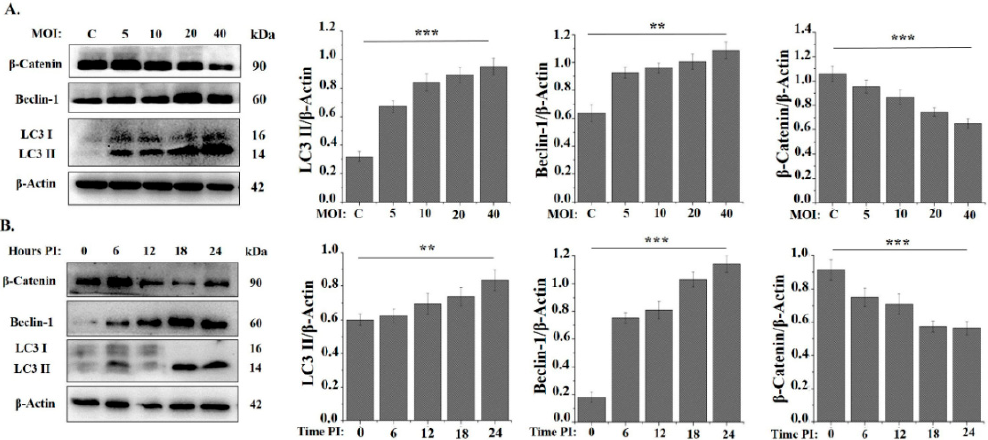
Figure 2. Mycobacterium bovis C68004 ( M. bovis ) infection induces autophagy in murine bone marrow derived macrophages (BMDMs) in a dose- (MOI) and time-dependent manner. ( A ) Murine BMDMs were infected with M. bovis C68004 at a variable MOI (5, 10, 20 and 40) and incubated for indicated time period. Expression of autophagic markers like LC3 II, Beclin-1 and β -Catenin was determined by the Western Blot analysis in infected and un-infected control BMDMs; ( B ) murine BMDMs were infected with M. bovis C68004 at a MOI of 10 and incubated for indicated time periods (0, 6, 12, 18, 24 h). Expression of autophagic markers was determined by the Western Blot analysis and expression levels of various proteins were normalized to β -Actin. Data represent the mean ± SD of three independent experiments (** p < 0.01; *** p < 0.001).